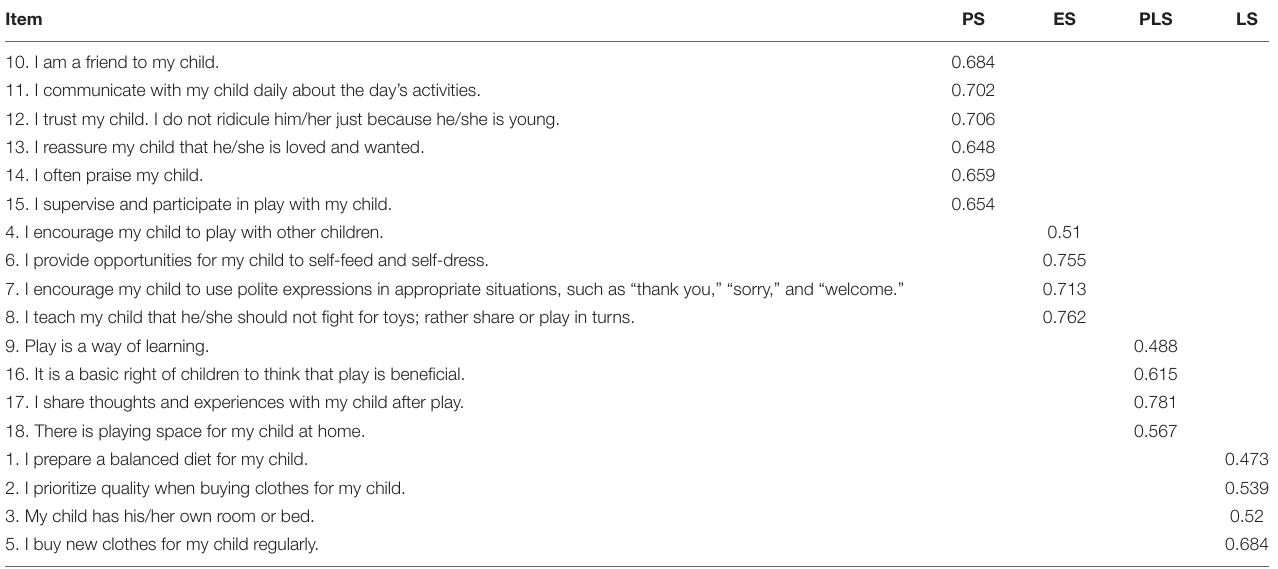
TABLE 9 | Results of Confirmatory Factor Analysis ( n =